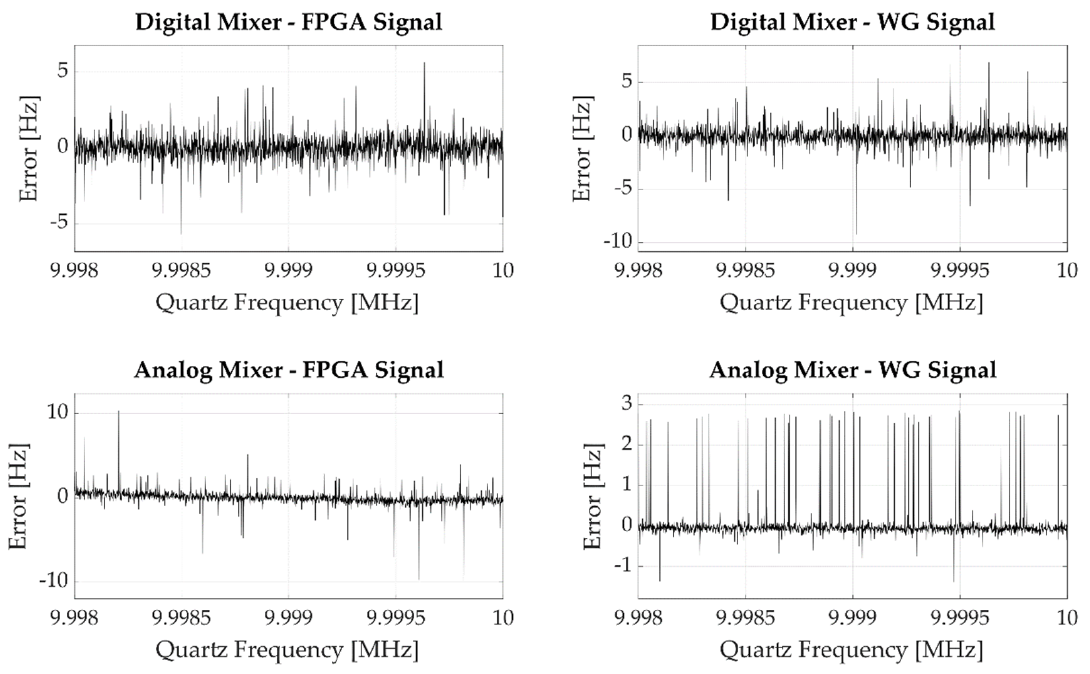
Figure 9. Experimental error observed while performing 100 measurements for each generated frequency. The four plots show the results obtained mixing the input signal using the digital or the analog mixer along with the signal generated by the FPGA or by the waveform generator.